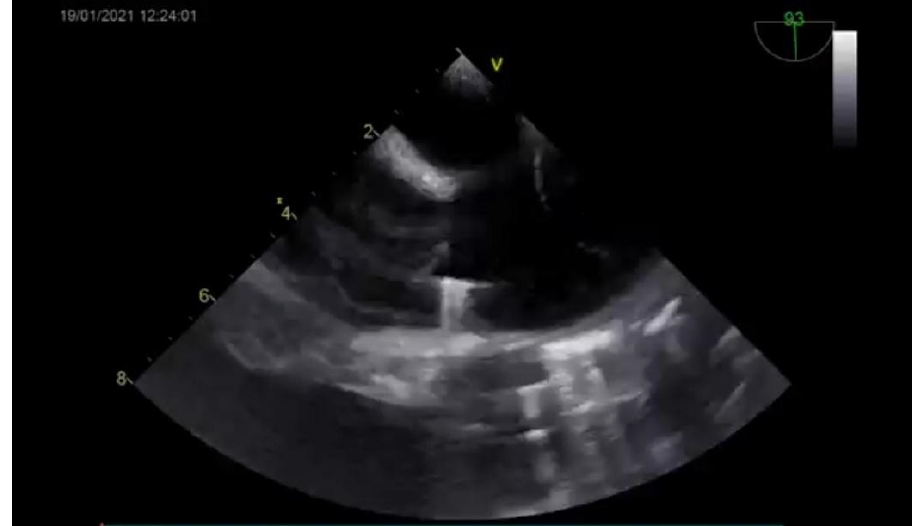
Figure 2. Preoperative echocardiography (bicaval view) showing the ASD.